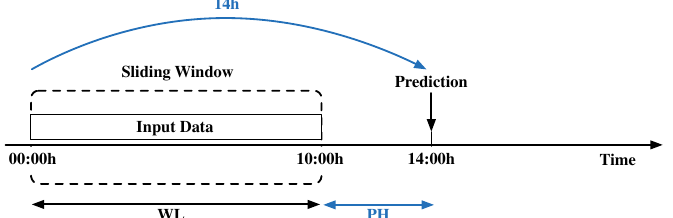
Figure 4. Sliding window structure. Notice that window length (WL) and prediction horizon (PH) correspond to 10 and 4